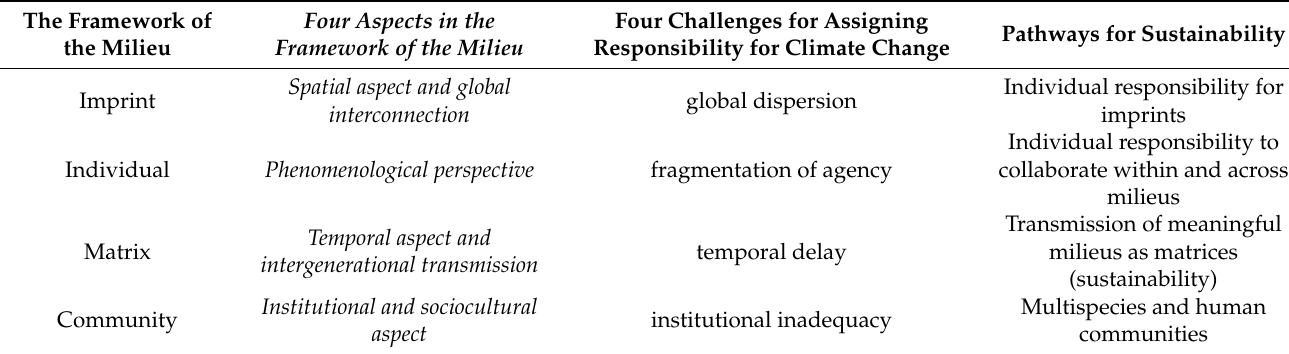
Table 1 synthesizes the four facets of the framework of the milieu (imprint, individual, matrix and community) and the four aspects that they reflect (a spatial aspect, the phenomenological perspective, a temporal aspect, and an institutional and sociocultural aspect), and mirrors them to the four challenges for assigning responsibility for climate change (global dispersion, fragmentation of the agency, temporal delay and institutional inadequacy), and the pathways for sustainability developed in this article in response to these challenges. Source : Original by the